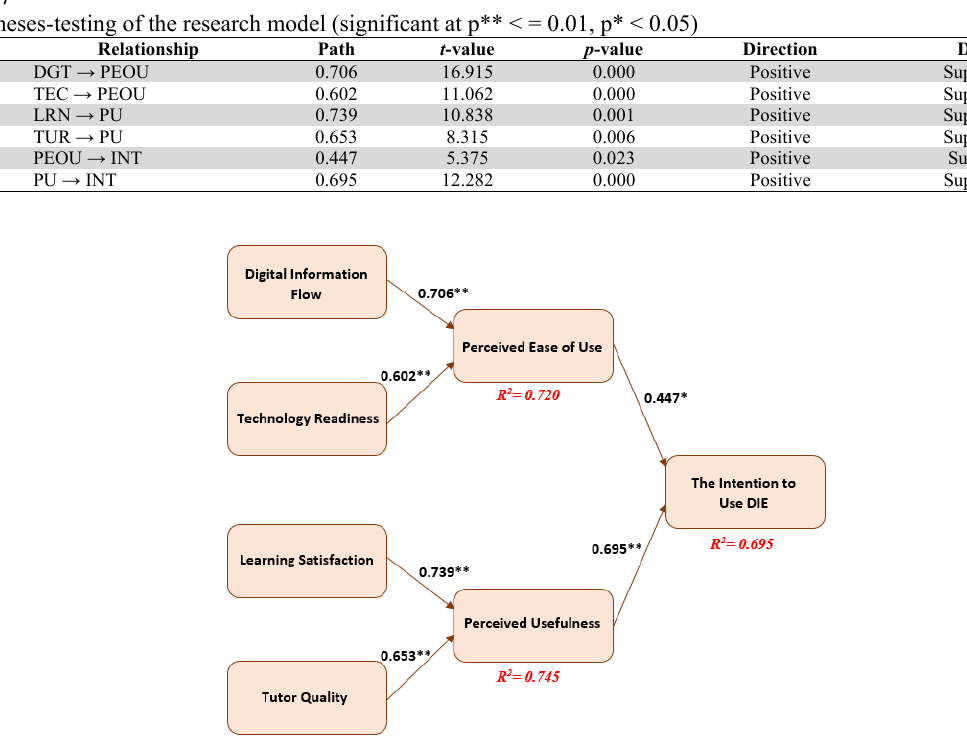
Fig. 2. Path coefficient of the model (significant at p** < = 0.01, p* <